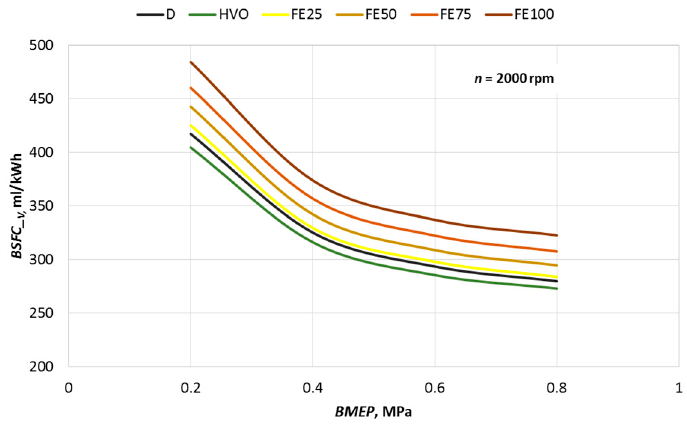
Figure 7. Dependence of BSFC_V, ml/kWh on the